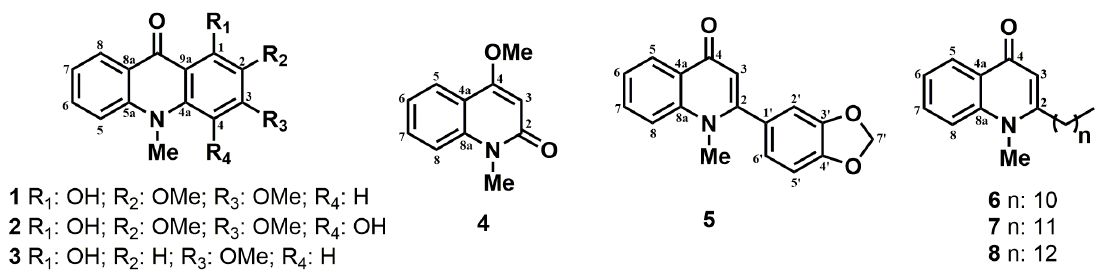
Figure 1. Alkaloids isolated from Ruta graveolens .